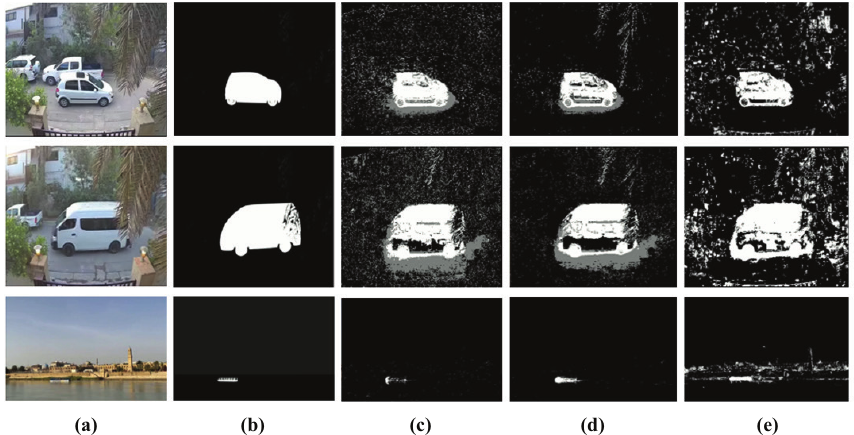
Fig. 8. Comparison of foreground detection results (a) original scenes (b) ground-truths